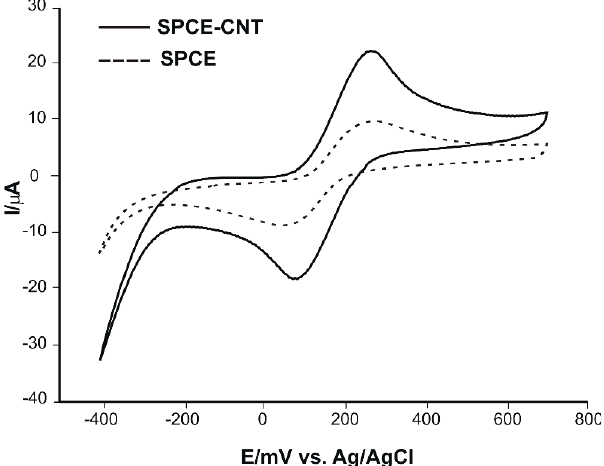
Figure 2. Cyclic voltammograms of the screen-printed carbon electrode modified with carbon nanotubes (SPCE)-CNT (solid line) and screen-printed carbon electrode (SPCE) (dashed line) in 0.001 M K 4 [Fe(CN) 6 ] solution registered with the scan rate of 0.1 V·s − 1 . Figure 3. Cyclic voltammograms of the SPCE-CNT (solid line) and SPCE (dashed line) immersed in a 0.001 M catechol solution registered with a scan rate of 0.1 V·s − 1